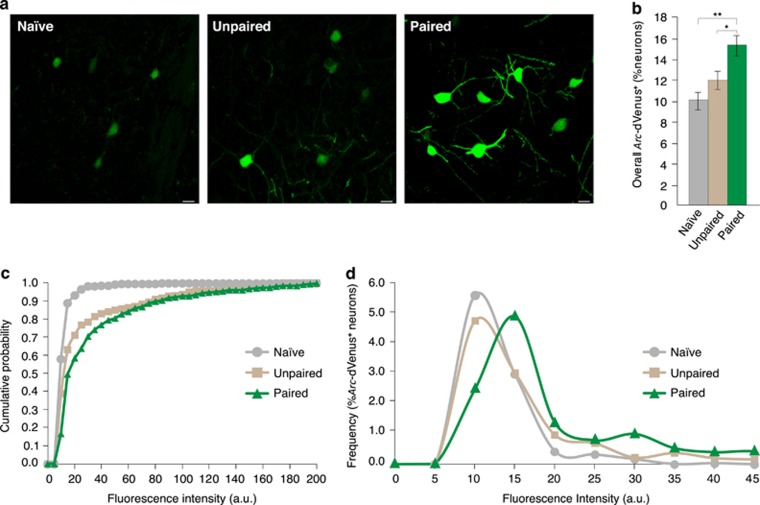
Arc-dVenus expression is selectively induced by fear learning. (a) Native dVenus fluorescence from naïve, unpaired and paired mice at 5 h post training. Scale bar, 10 μm. (b) Stereological quantification of Arc-dVenus+ neurons in naïve, unpaired and paired conditions. Paired training significantly increases the percentage of Arc-dVenus+ cells compared with naïve and unpaired controls. In contrast, a similar percentage of Arc-dVenus+ cells is observed between naïve and unpaired conditions (Naïve: n=7 mice, Unpaired: n=7 mice, Paired: n=6 mice). One-way analysis of variance, F=8.59, P<0.01. (c) Cumulative distribution of Arc-dVenus fluorescence intensity. Fluorescence intensity is significantly higher in mice receiving paired fear conditioning, compared with naïve and unpaired controls. Kolmogorov-Smirnov: Naïve versus Paired, D=0.48, P<0.0001; Unpaired versus Paired, D=0.24, P<0.001. (d) Frequency histograms of Arc-dVenus fluorescence intensity. x axis is truncated at 45 a.u. (Panels c and d: bin size, 5 a.u.). *P<0.05, **P<0.01, ***P<0.001.